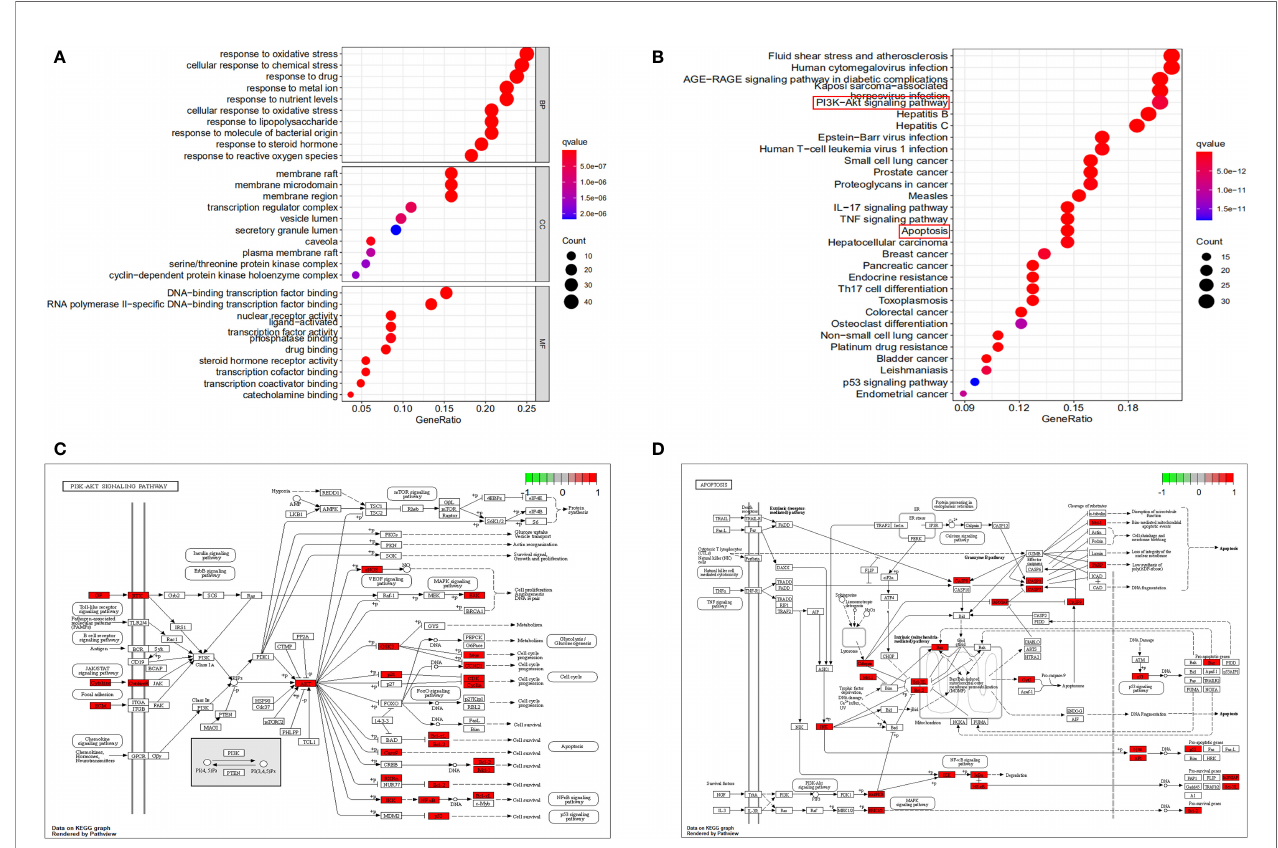
FIGURE 3 | GO and KEGG functional analysis. (A) The top 10 of GO enrichment analysis in Biological processes (BP), cellular components (CC) and molecular function (MF). (B) The top 30 signaling pathways were analyzed by KEGG. (C, D) The PI3K-Akt signaling pathway (C) and apoptosis (D) were described in detail. The larger the nodes, the darker the color, and the more genes were